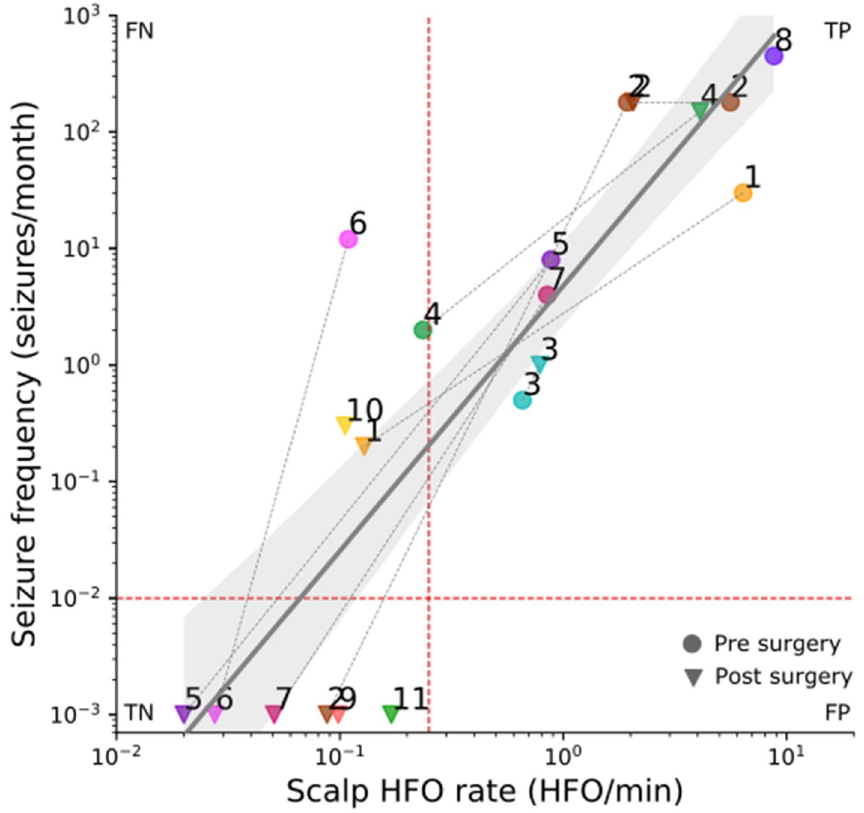
Figure 3. HFO rate mirrors seizure frequency. EEG recordings before (circles) and after (triangles) epilepsy surgery were pooled across our patient cohort. Each point in the plot corresponds to an EEG recording and indicates the seizure frequency and HFO rate at the time of the EEG recording. Axes are on a logarithmic scale. For illustrative purpose, seizure freedom was approximated by 10 –3 seizures/month so that only a seizure frequency > 10 –2 seizures/month indicates active epilepsy (horizontal red line). If the HFO rate exceeded the rate threshold of 0.25 HFO/min (vertical red line), the recording was defined as showing HFO. The recordings from ten patients with active epilepsy were above this threshold (TP = 10), while the recordings from four patients with active epilepsy were below this threshold (FN = 4). After their surgery, patients 2,5,6,7,9,11 were seizure- free, and their HFO rate was below the threshold (TN = 6). The HFO rate in the scalp EEG correlated with seizure frequency (R 2 = 0.76, p < 0.0001, linear regression; rho = 0.90, p < 0.0001, Spearman’s correlation). TP True Positive; TN True Negative; FP False Positive; FN False